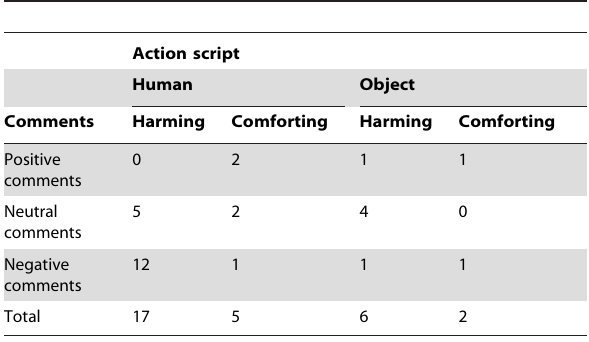
Table 1. Number of positive, neutral or negative comments during the four types of action scripts.